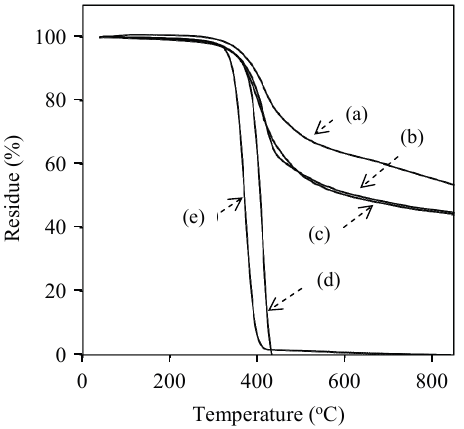
Figure 13. TGA curves of the cured films of oligo(P-4va) (a), P(P-4va/St) (b), and P(P-4va/MMA) (c), and PSt (d) and PMMA